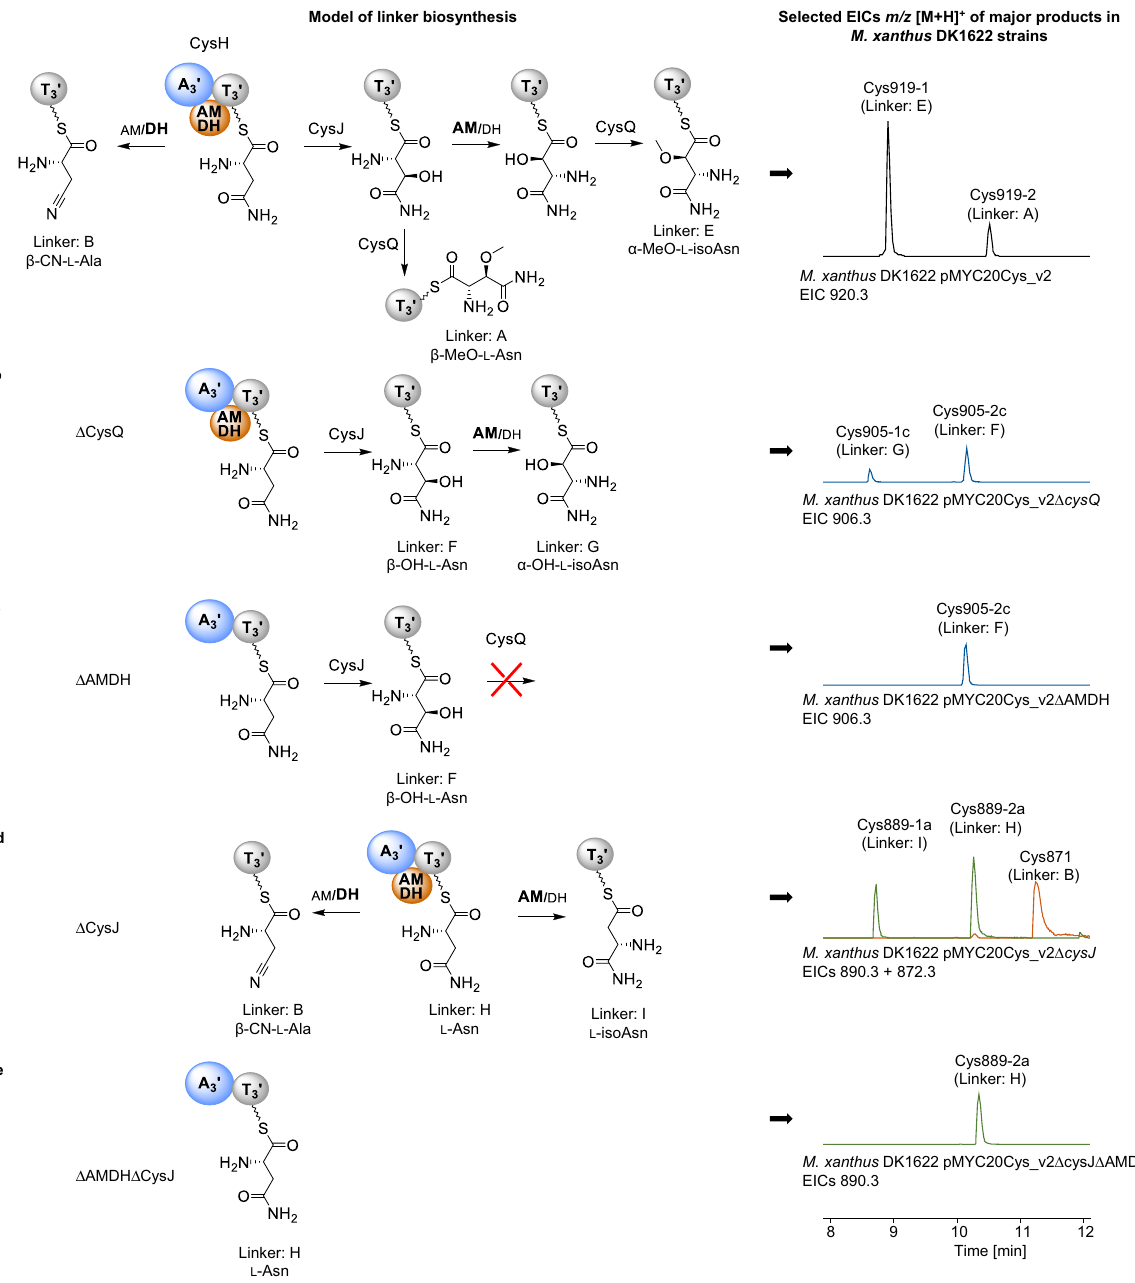
Fig. 5 Summary of biosynthesis pathways for cystobactamid linkers. a Hydroxylation of CysH-bound L -asparagine by CysJ with subsequent isomerization by AMDH plus O -methylation by CysQ leading to α -methoxy- L -isoasparagine (E linker); O -methylation without isomerization leads to β -methoxy- L - asparagine (A linker); direct dehydration by AMDH domain leads to the formation of β -cyano- L -alanine (B linker). EIC 920.3 [M + H] + (black) shows the production of Cys919-1 (E linker) and Cys919-2 (A linker) in M. xanthus DK1622 pMYC20Cys_v2. b Absence/deletion of CysQ leads to the formation of β - hydroxy- L -asparagine (F linker) or α -hydroxy- L -isoasparagine (G linker) after isomerization by AMDH. EIC 906.3 [M + H] + (blue) shows the production of Cys905-1c (G linker) and Cys905-2c (F linker), which lack one methyl group in the linker compared to Cys919 ( − 14 Da shift). c Deletion of the AMDH domain leads to hydroxylation of CysH-bound L -asparagine by CysJ, but O -methylation by CysQ does not occur (only formation of β -hydroxy- L - asparagine/production of Cys905-2c). d Absence/deletion of CysJ leads to the formation of L -asparagine (H linker), L -isoasparagine (I linker), or β -cyano- + (green) and EIC 872.3 [M + H] + (orange) shows the production of Cys889-1a (I linker), Cys889-2a L -alanine (B linker). Overlay of EIC 890.3 [M + H] (H linker) and Cys871 (B linker) e Deletion of CysJ and the AMDH domain prevents any modi fi cation of asparagine leading only to the production of Cys889-2a. Blue sphere: adenylation domain; gray sphere: thiolation domain; orange sphere: AMDH domain; red cross: nonfunctional overexpressed and puri fi ed CysB, CysH, and CysK-M3 from E. syringomycin biosynthesis 35 . Another CysB homolog, CmaE, was coli BL21. First, we analyzed the aminoacyl transfer reaction of shown to shuttle aminoacyl groups between carrier protein domains in coronamic acid biosynthesis 36 . With CysB being our L -asparagine from CysH to CysB using protein MS. We used candidate enzyme for the hypothesized shuttling process, we commercially available L -asparagine instead of methoxylated